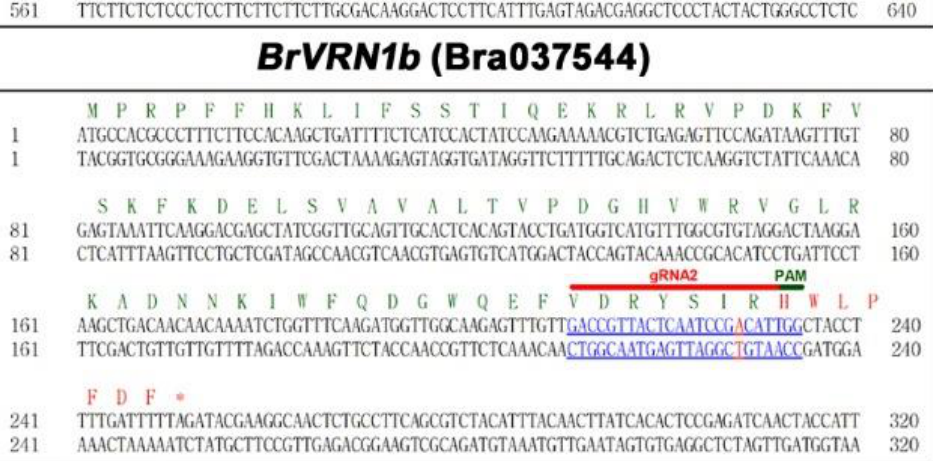
Figure 3. Nucleotide and deduced amino acid sequences of insertion variants of BrVRN1 homologs in #2 GE1 mutant lines. Nucleotide residues are numbered starting with the methionine initiation codon (ATG). The deduced amino acid sequences are presented by a single letter code above the nucleotide sequence. The original amino acid sequences and changed codes are colored in green and red, respectively. The stop codon is denoted by an asterisk.